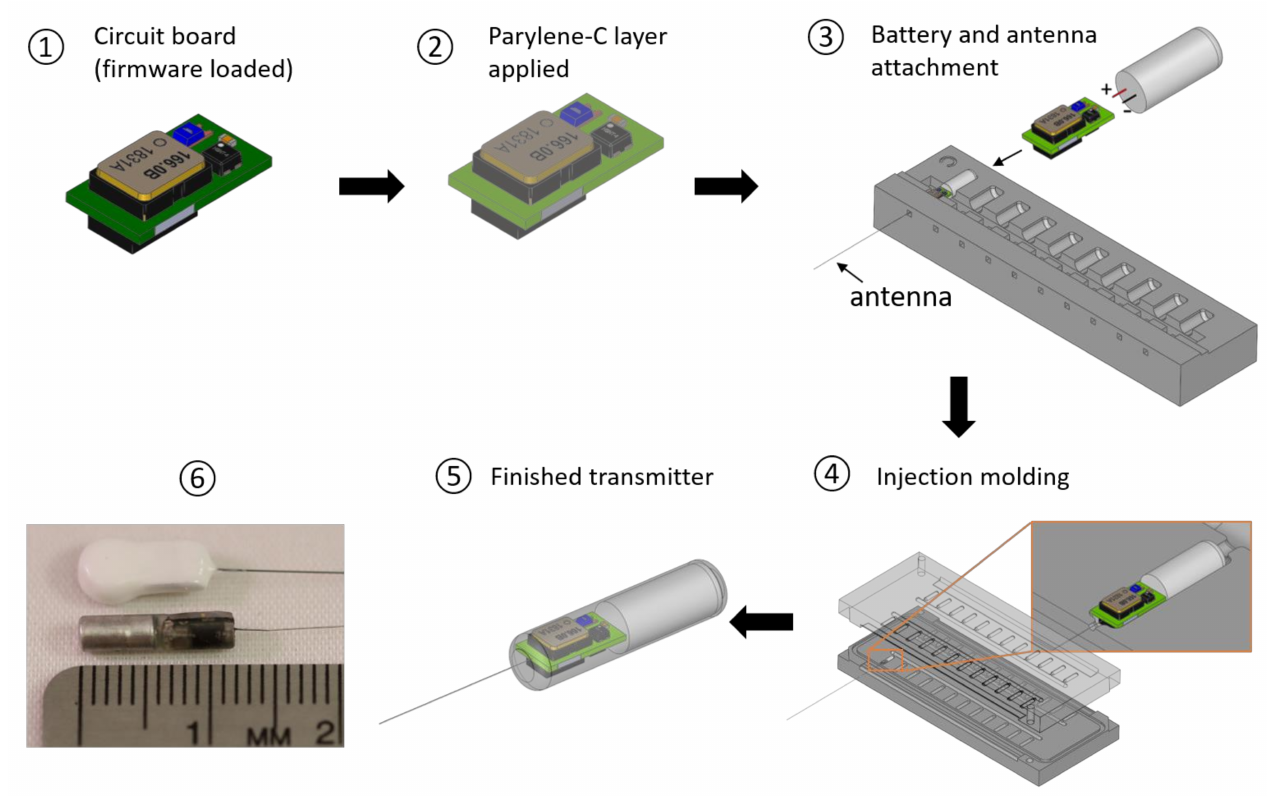
Figure 3. The manufacturing process for the RF transmitter and close-up view: ( 1 ) manufacture of the thin two-layer PCB with components; ( 2 ) thin-film parylene-C layer deposition; ( 3 ) attachment of the micro-battery and antenna; ( 4 ) encapsulat- ing the transmitter assembly using epoxy; ( 5 ) the CAD drawing of the Option 2 capsule design; ( 6 ) Lotek NTQ-2 (top) and the prototype of the modulated RF transmitter